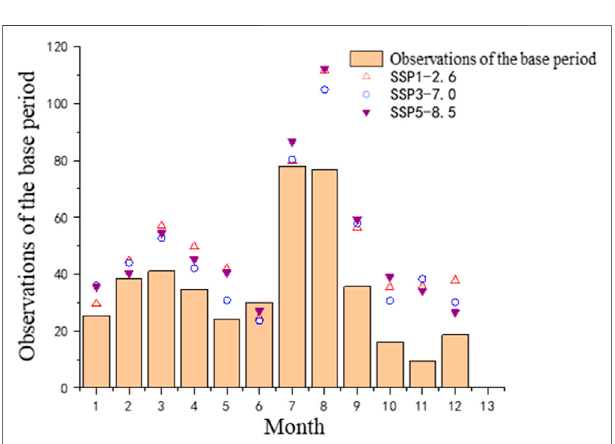
FIGURE 7 | Monthly average precipitation in the base period and monthly average precipitation in three combined paths from 2021 to 2050.